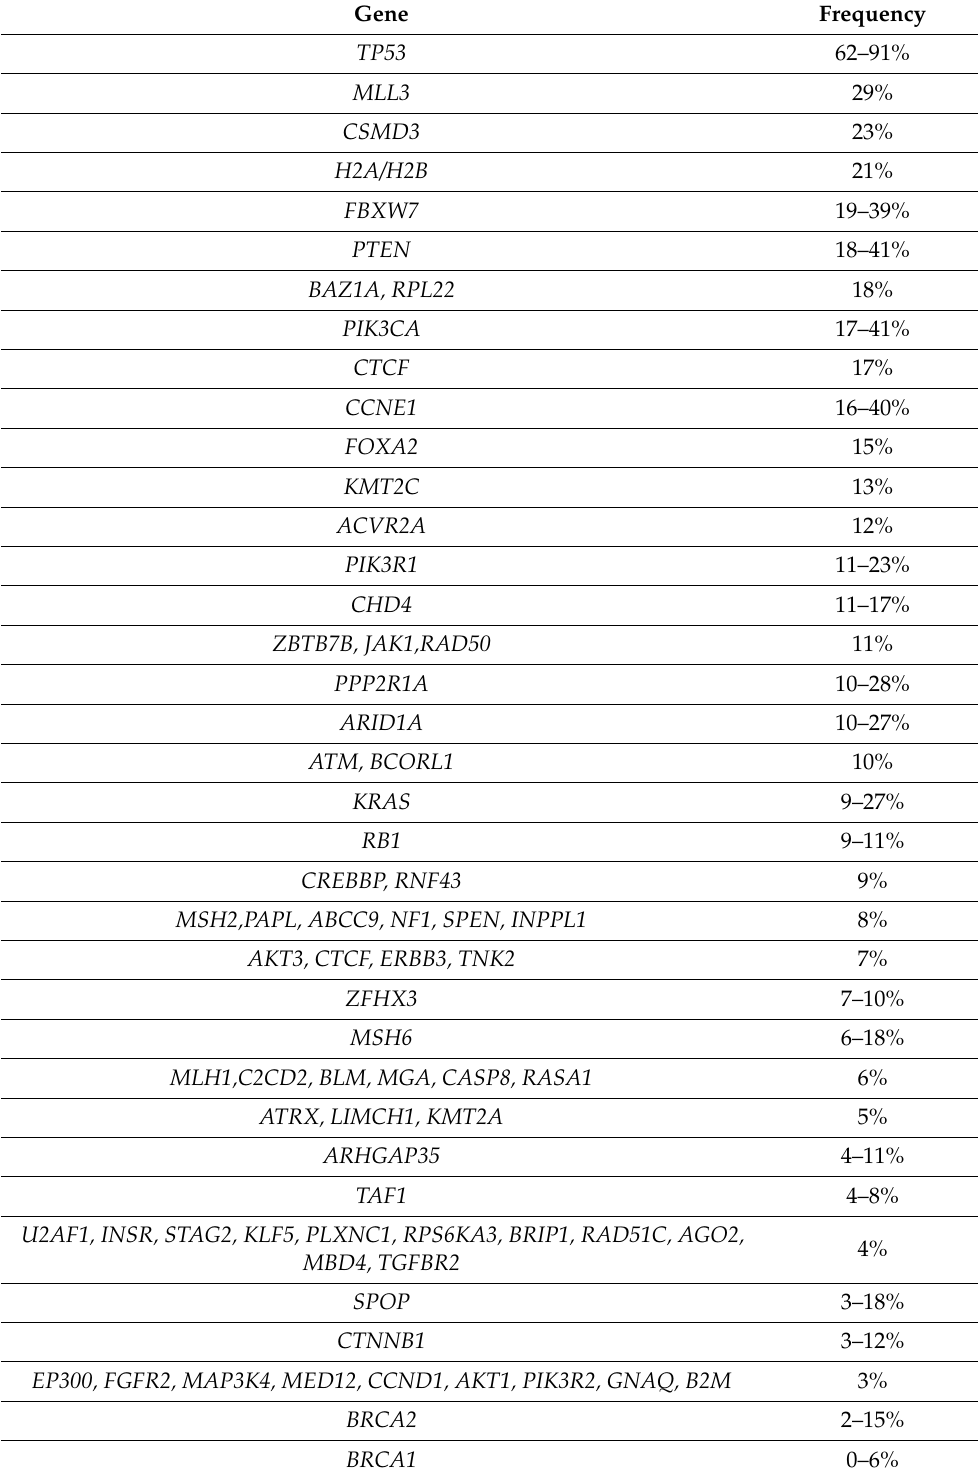
Table 1. Mutational profile summary for uterine carcinosarcomas